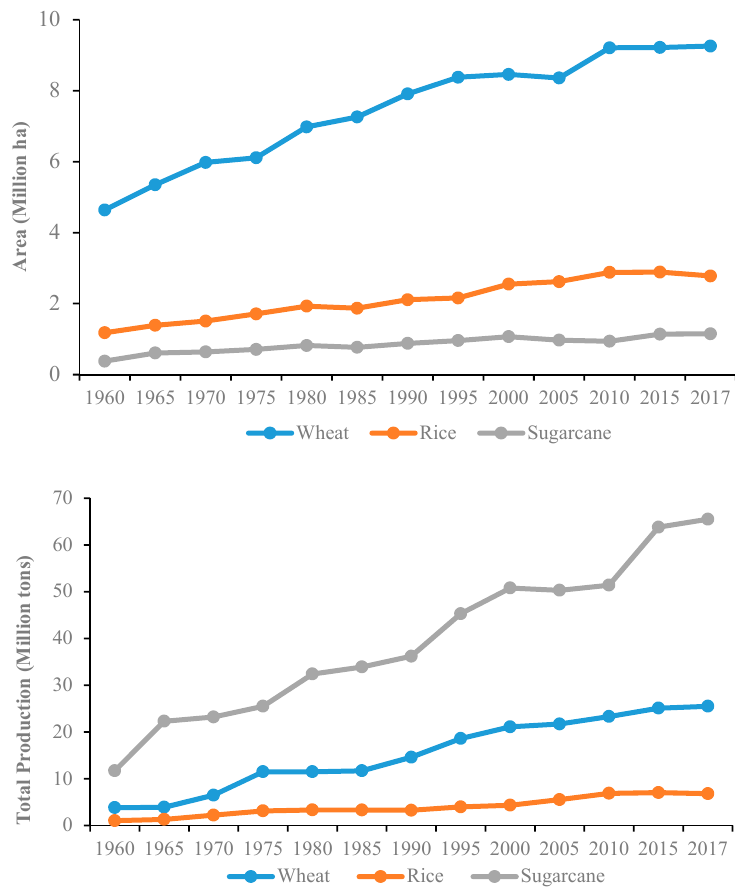
Figure 5. Development of cultivated area and production of three major crops in Pakistan (Source: Punjab Agricultural Statistical Department).